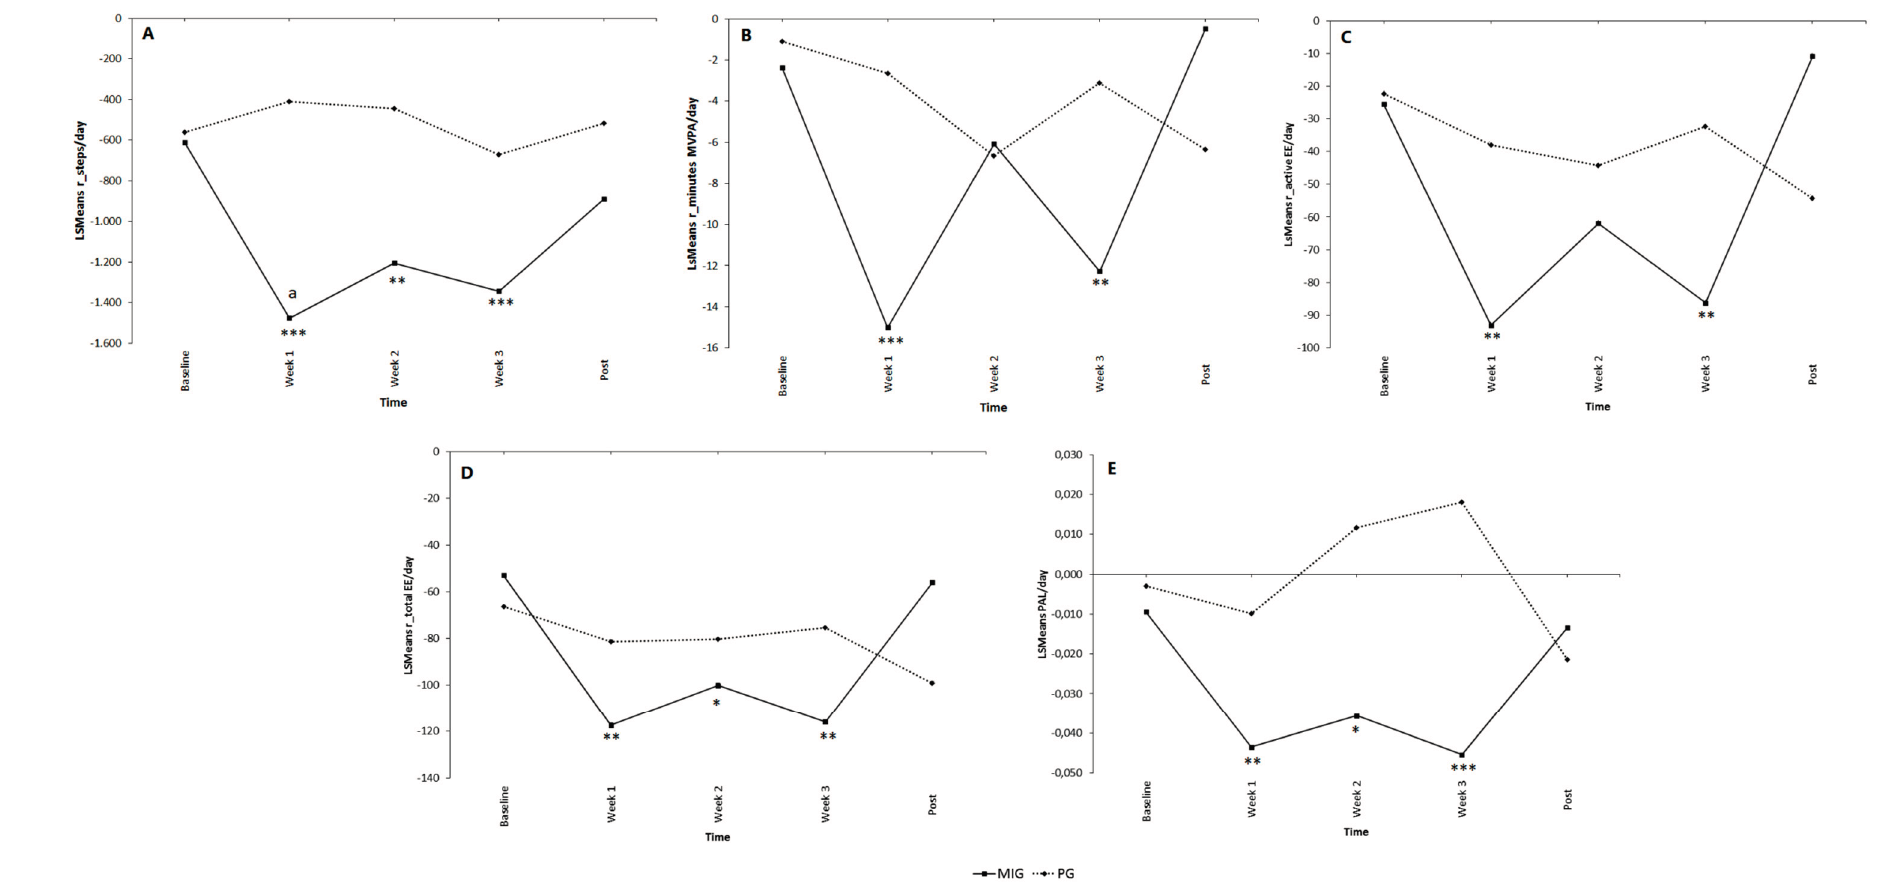
Figure 3. Residuals for steps ( A ); minutes of moderate to vigorous physical activity ( B ); total energy expenditure ( C ); active energy expenditure ( D ) and physical activity level ( E ) at baseline, week 1, week 2, week 3 and post 1 for the Minimal Intervention Group (MIG) and Pedometer Group (PG). Data are expressed as least square means (LSMeans). Between subjects and within subjects effects are shown. The letter a indicates a significant difference between MIG and PG at p < 0.05; an asterix (*) indicates a significant difference to baseline measurement within the MIG and PG; * p < 0.05; ** p < 0.01; *** p <